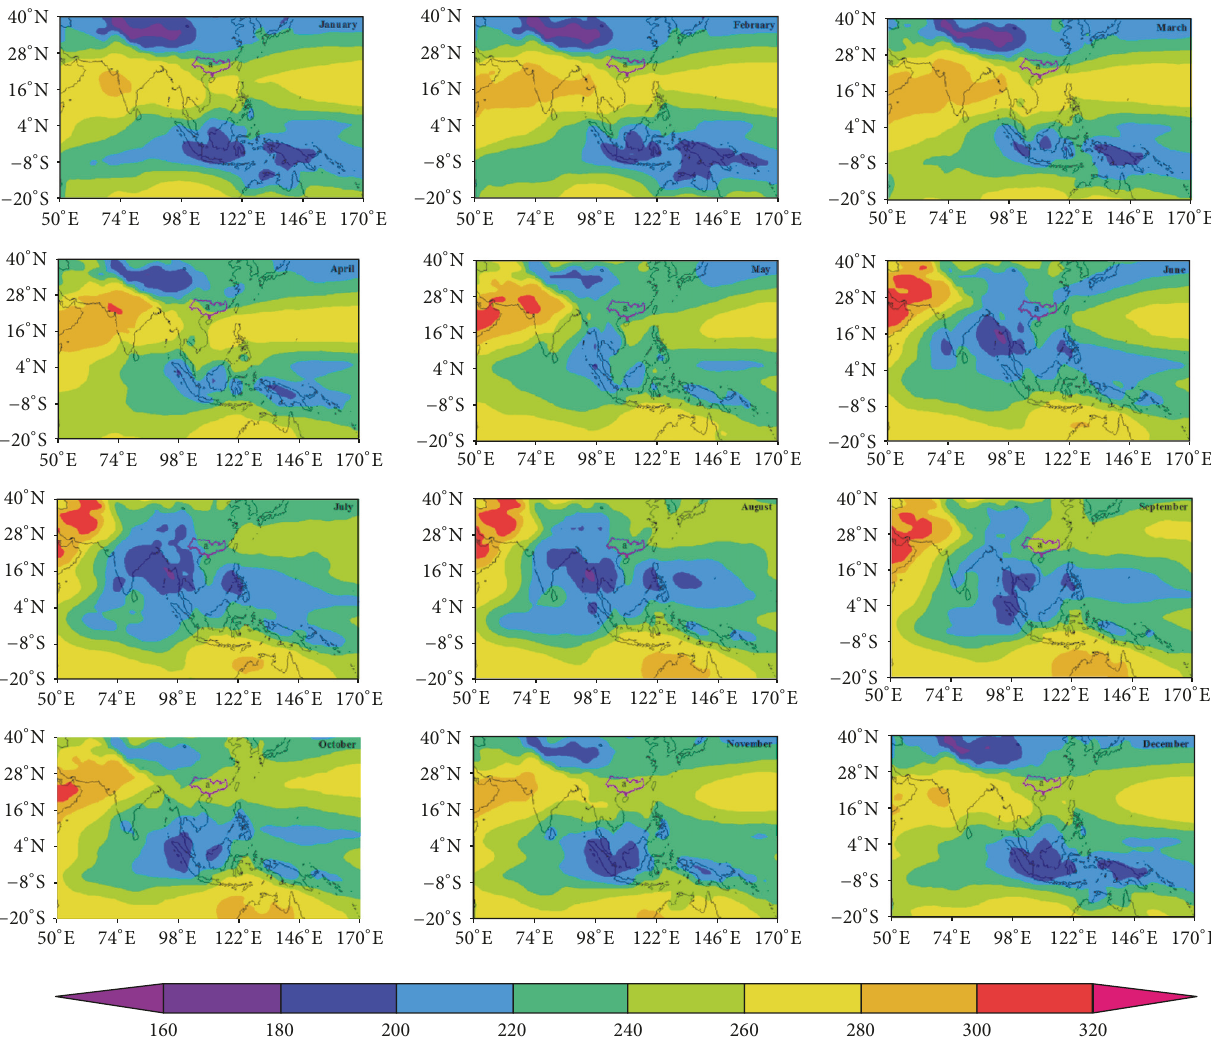
Figure 4: Variations of mean OLR for each month from 1980 to 2011 over Pearl River basin (a) and adjacent regions. Note: the unit of the color scale is W/m 2